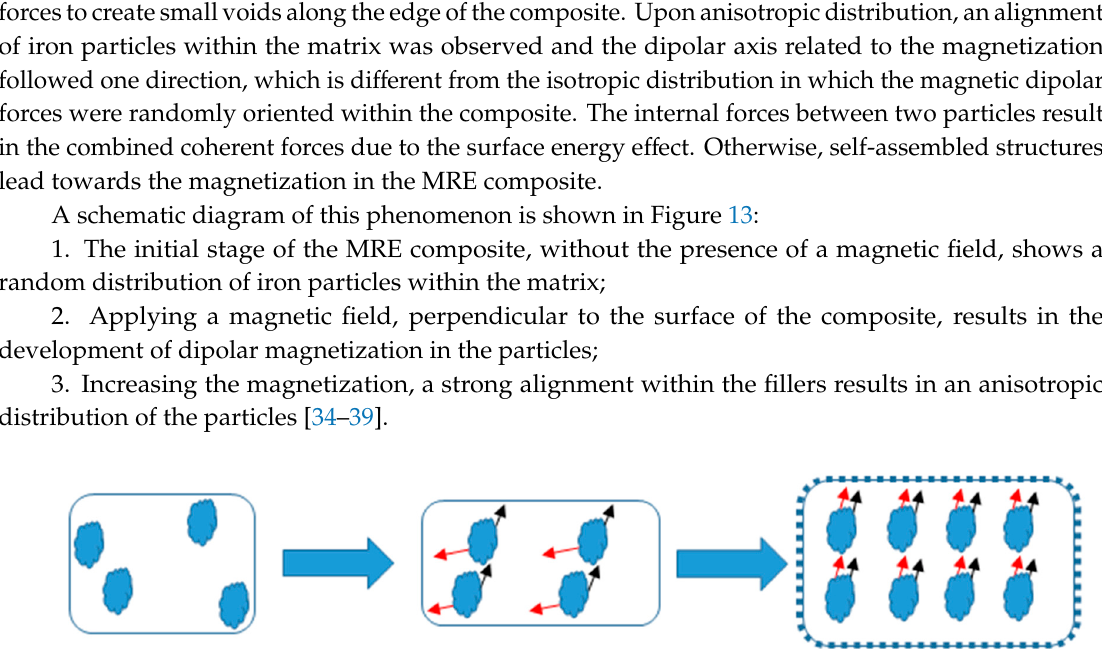
Figure S1: Magnetic forces theoretical prediction using various magnetic currents as a function of compression shift position, Figure S2: Magnetic inductions theoretical prediction using various magnetic currents as a function of compression shift position, Figure S3: Carbonyl iron (CI) particles of size range 1–5 µ m within the MRE composite, Table S1: Measured values of magnetic force and induction at various current and compression position of the magnetorheological elastomer (MRE)